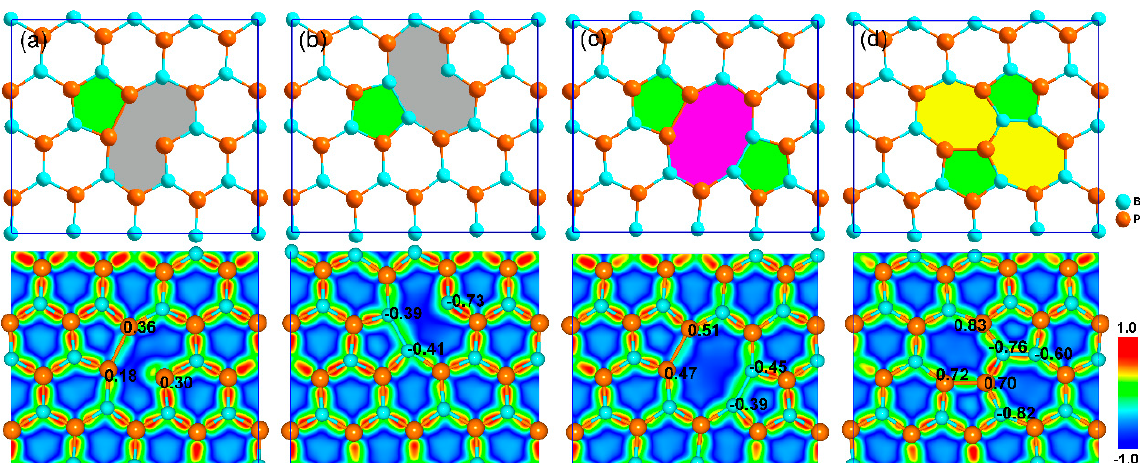
Figure 2. Optimized geometrical structures (up panel) and difference of charge densities (down panel) for defective boron-phosphide monolayers: ( a ) B_v, ( b ) P_v, ( c ) D_v, and ( d ) S-W defects. The value presented in the charge density is the Bader charge amount (unit in e ) for the corresponding atom around the defect. Positive and negative values represent gaining and losing electrons.